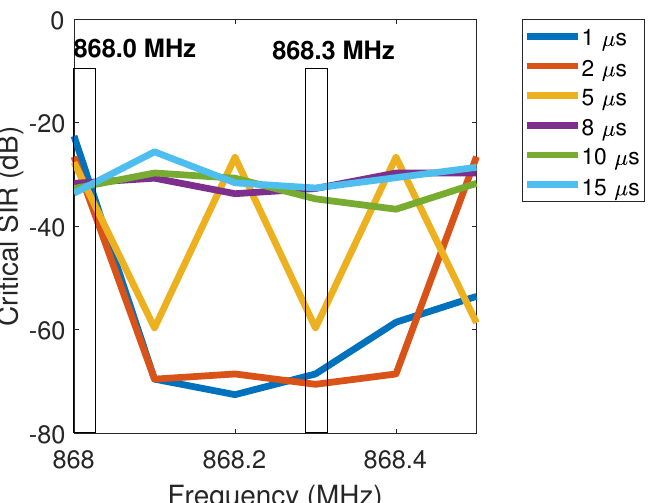
Figure 9. Critical SIR levels as a function of the LoRa frequency channel. Jamming signal parameters: 840 MHz to 980 MHz, variable sweep period. LoRa parameters: SF = 7, CR = 4/5, B = 125 kHz. The two channel frequencies which were previously evaluated through the different error indicators are